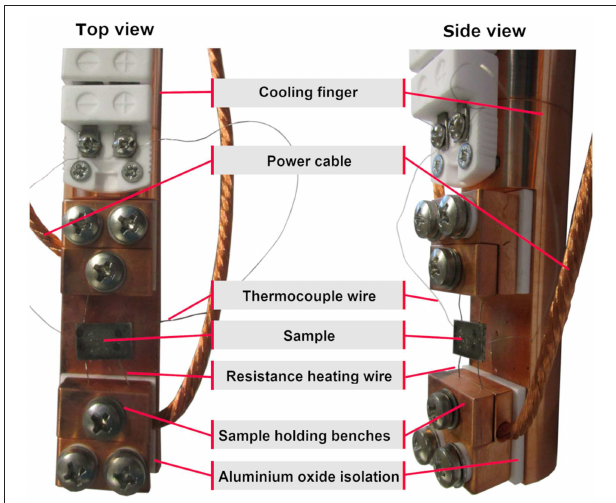
FIGURE 2 | Sample holder of the TPD-System, top view and side view.